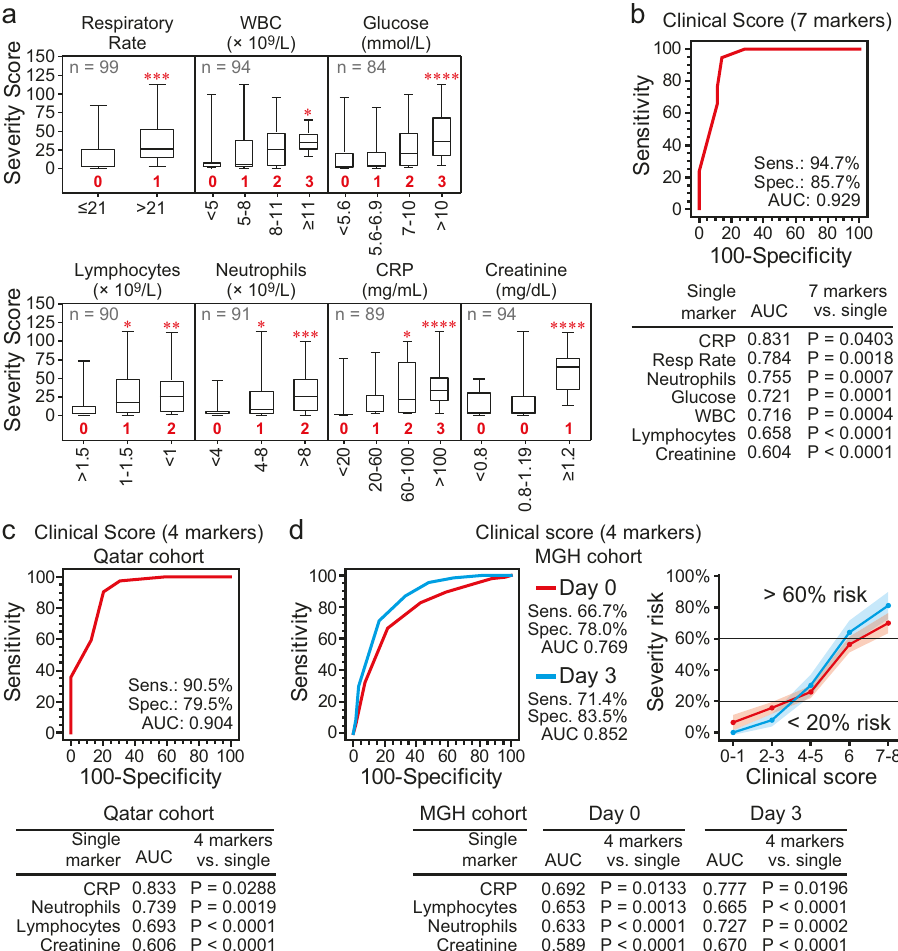
Fig. 7 A clinical risk score for COVID-19 complications based on the 12-protein molecular severity score. a The clinical parameters available in the cohort were evaluated for their association with the 12-protein molecular severity score to identify signi fi cantly associated parameters and allow scoring (weighting) for the different groups in each clinical measurement. The box plots (median as center line, box marks the 25th and 75th percentiles, and whiskers de fi ne minimum and maximum) show the molecular severity score across the groups in the most associated clinical parameters; the number of patients (total of 100, 50 severe, and 50 non-severe) with data available for each parameter is stated in each panel. One-way ANOVA with Dunnett ’ s multiple testing correction was used for clinical parameters with more than two groups, and unpaired two-tailed t -test was used for parameters with two groups. Refer to Supplementary Data 6 for more details of the statistical comparisons and exact p -value. The groups in each of the seven selected clinical parameter (markers) were given a numeric, integer value from 0 to 3 (shown in red bold font) according to the 12-protein severity score. These values were then used to calculate the Clinical Risk Score by adding the values across the 7 markers for each patient. Refer to Supplementary Fig. 6 for details of variable selection. b ROC curve analysis con fi rmed the signi fi cant predictive value of the Clinical Risk Score, which combined the 7 clinical markers. c , d Of the 7 markers in ( a ), 4 (CRP and creatinine levels and lymphocyte and neutrophil cell counts) were available in the MGH cohort, thus, were used for independent validation (Supplementary Data 5). c , d Show the ROC curve of the Clinical Risk Score based on the 4 markers in our cohort from Qatar and the MGH cohort (from day 0 and day 3 data) from the US, respectively. D Also shows the risk of COVID-19 severity (% risk with 95% con fi dence interval) in the MGH cohort according to the 4-marker Clinical Risk Score. For b – d the Clinical Risk Scores outperformed each of the single clinical parameters in pairwise comparisons ( p < 0.0001, DeLong et al. method 70 responses and elicits T cell anergy or activation of Treg or T suppressor cells 24 – 26 , and PVR (CD155) which is a ligand for CD226 (DNAM-1) and TIGIT expressed on NK cells and a subset of T cells 27 , but the soluble form inhibits NK cells CD226- mediated cytokine production 28 . NECTEN2 (also called PVRL2), a ligand for DNAM-1 and PVRIG on NK and T cells 27 , has a